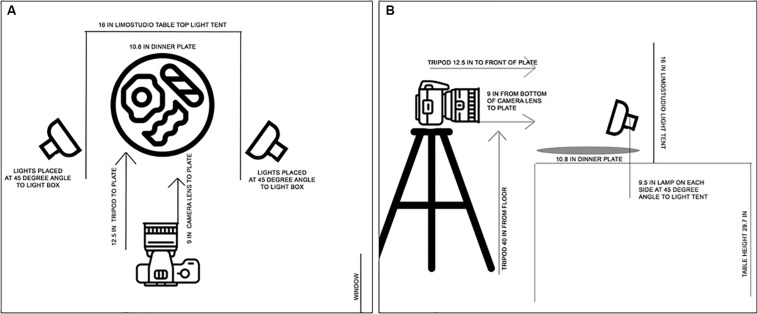
Diagram depicting placement of food or office supplies on a plate in relation to camera, tripod. lights. and light box used in photography protocol. (A) Shows the bird’s-eye view of the equipment and objected of interest photographed by the professional photographer. (B) Shows the eye level view of the equipment and object of interest photographed by the professional photographer.